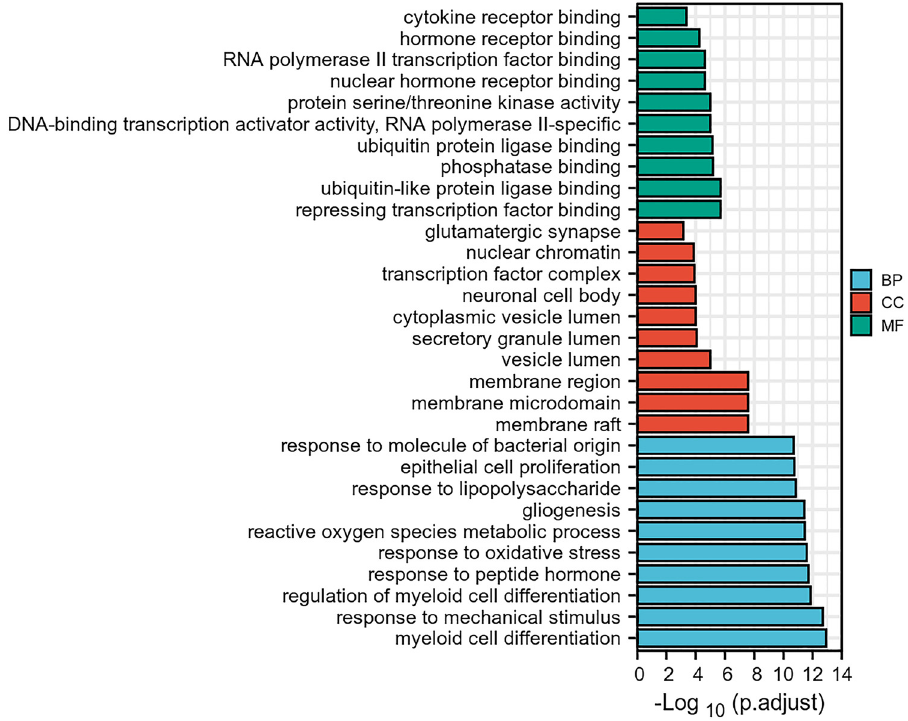
Figure 5: GO functional analysis. GO terms and − log10 ( p adjust ) are represented by the x - axis and y - axis, respectively.